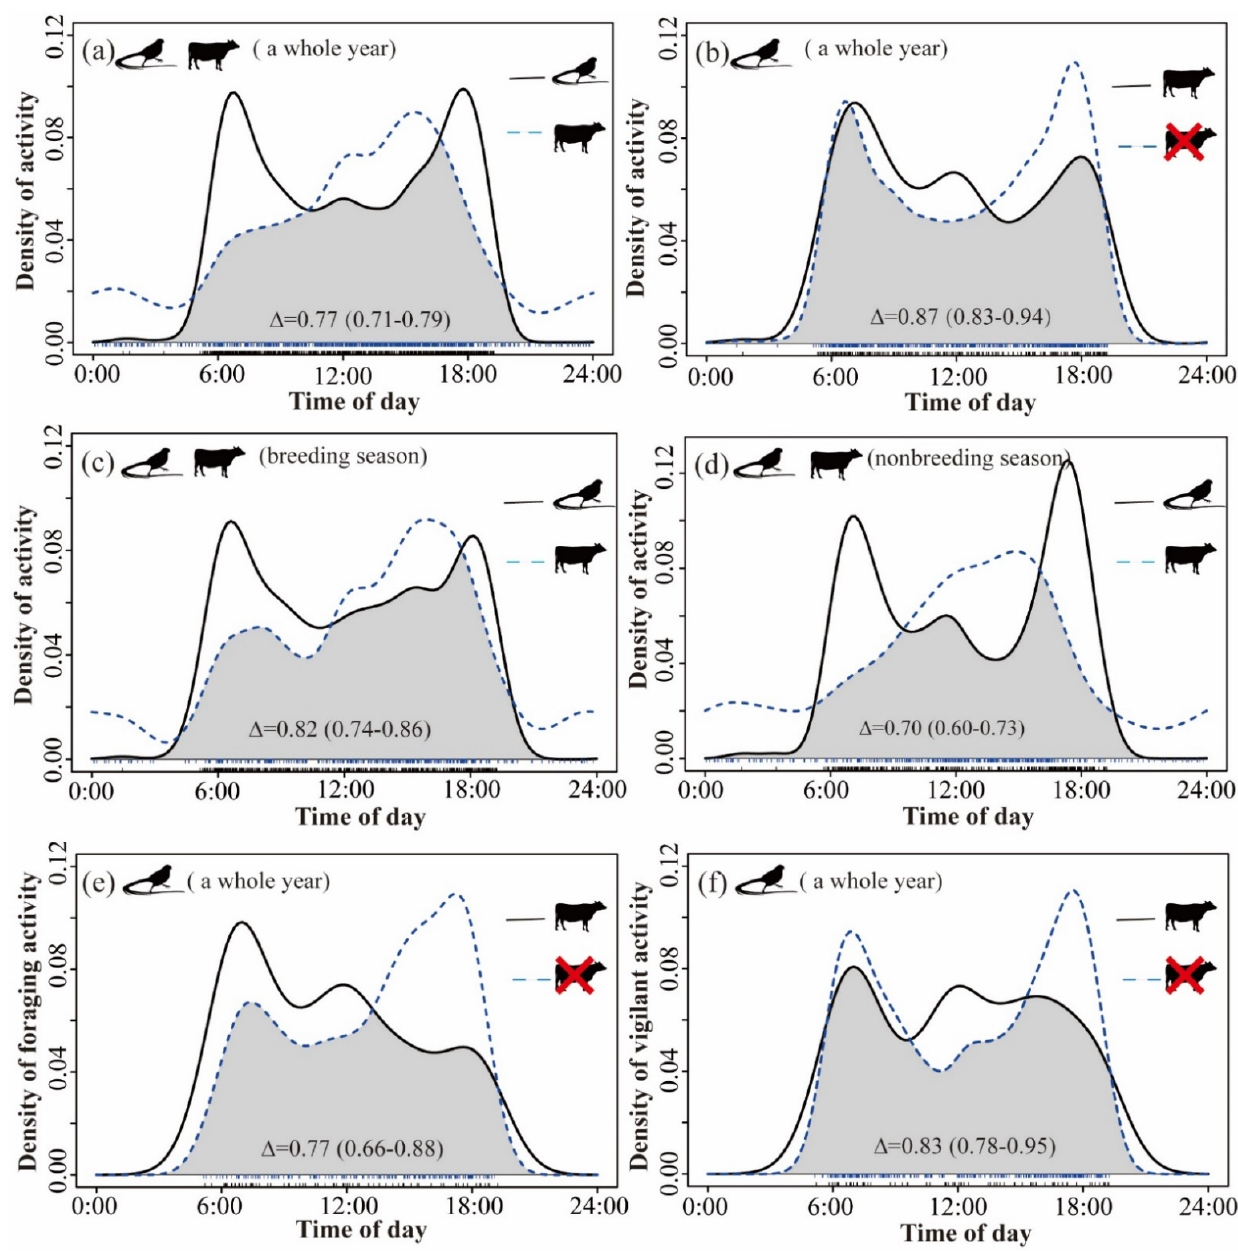
Figure 4. Activity pattern of Reeves’s Pheasant and livestock. Probability density distribution and overlap throughout the day for breeding season or nonbreeding season or the year in LKS and ZHS. Black silhouettes with long tails refer to Reeves’s Pheasant, and another to livestock. ( a ) Overlap in diel activity patterns of Reeves’s Pheasant and livestock throughout the year. The influence of livestock presence on the diel activity patterns of Reeves’s Pheasant ( b ). ( c , d ) The overlap of daily activity patterns of livestock and Reeves’s Pheasant in breeding season and non-breeding season, respectively. ( e , f ) The influence of livestock presence on foraging behaviour and vigilant behaviour pattern of Reeves’s Pheasant.